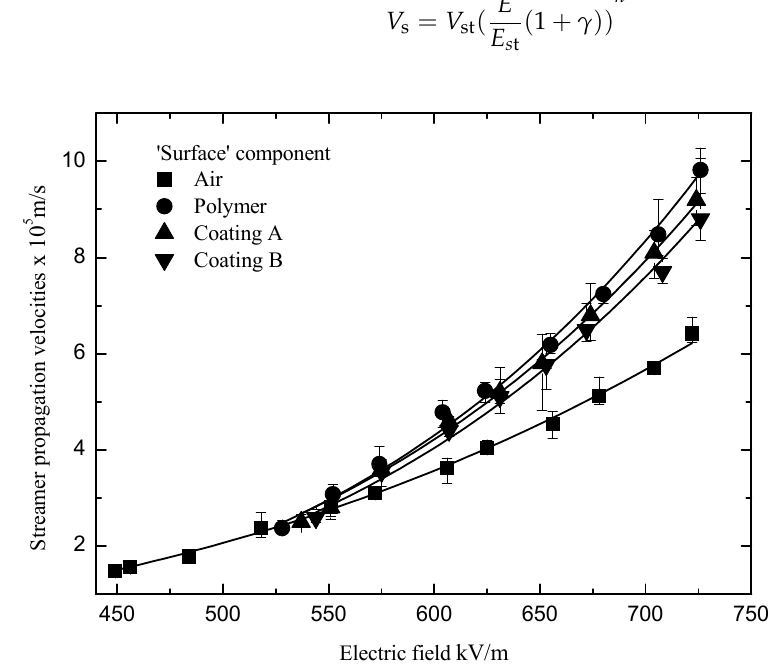
Figure 8. Velocities of the ‘surface’ components under the varied electric fields.